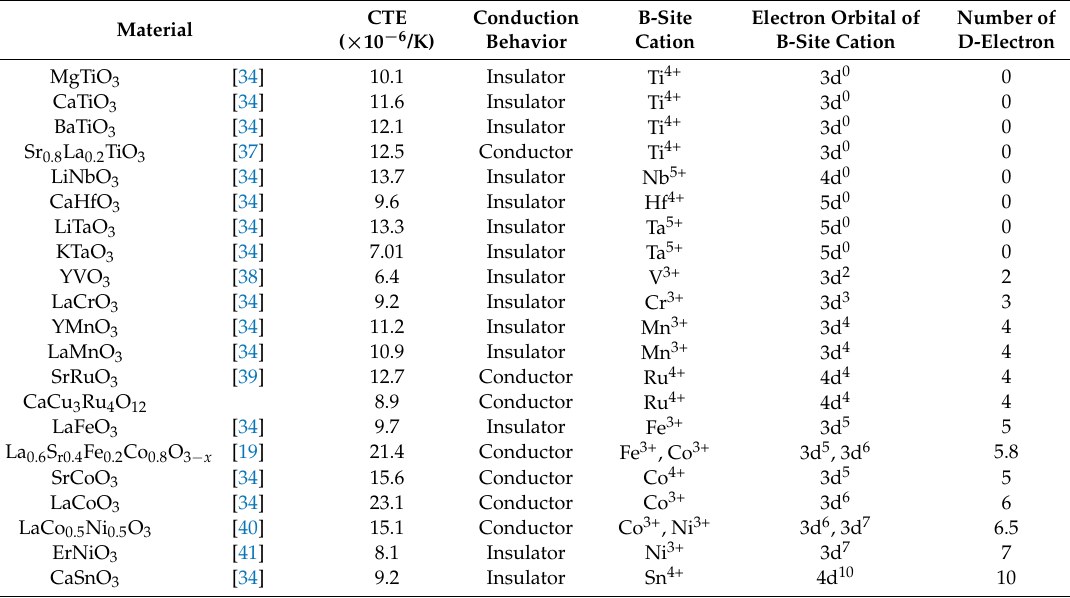
Table 1. CTE, conduction behavior, B-site cation, electron orbital of B-site cation, and number of d-electron of various perovskite